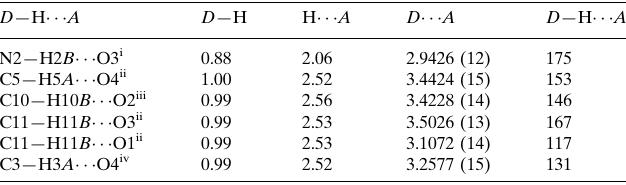
Data collection Oxford Diffraction Gemini diffractometer